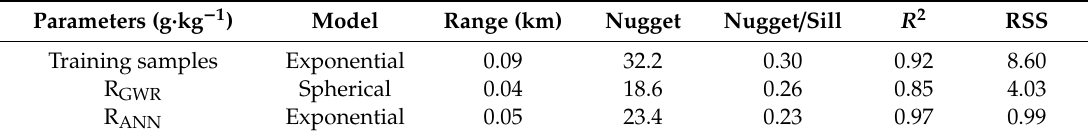
Table 4. Semivariogram parameters for SOC observations and the residuals of geographically weighted regression (GWR) and artificial neural network (ANN).